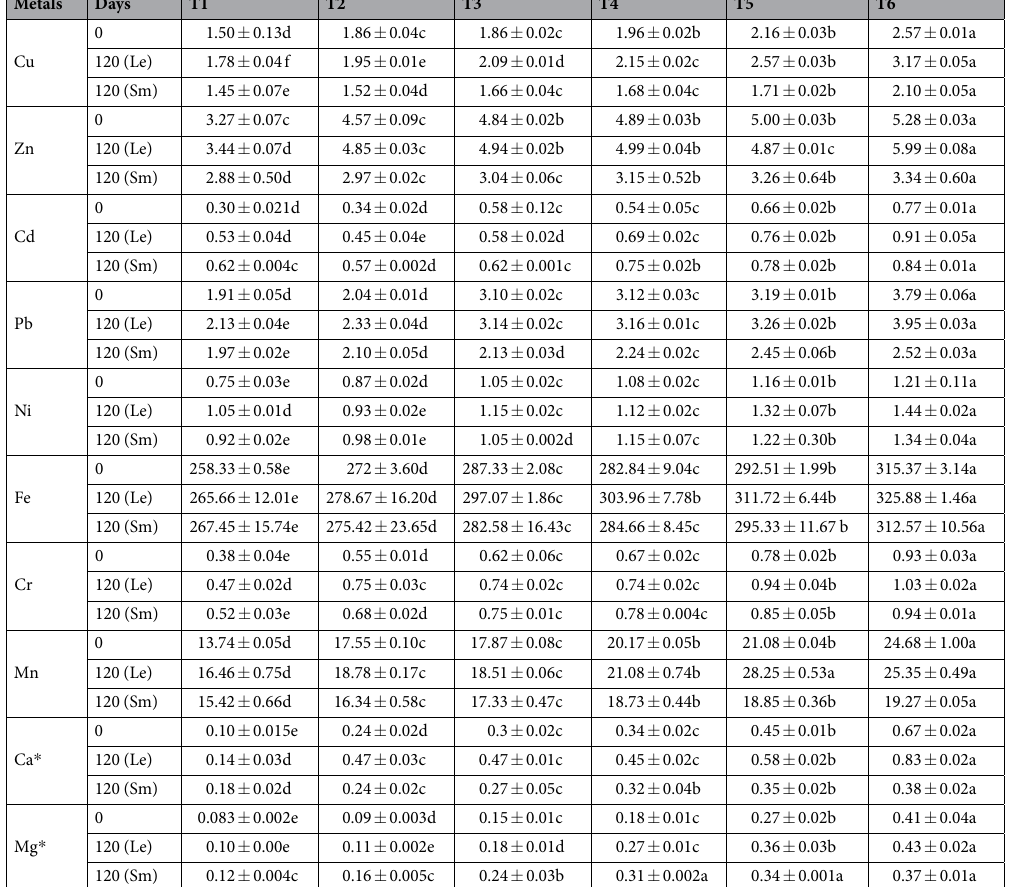
Table 2. Metal concentrations (mg/kg) of vermicomposted fly ash amended soil during sowing and harvesting of Lycopersicon esculentum and Solanum melongena . Le : Lycopersicon esculentum ; Sm : Solanum melongena ; Ca * and Mg * : Values of Ca and Mg are in percentage (%). Values are in Mean ± SD; (n = 3). Different letters in the same row represent significant differences in the mean of the metal concentrations of different treatments comprising L . esculentum and S . melongena at p < 0 . 05 according to Duncan’s Multiple Range Test (One-way ANOVA followed by Tukey’s